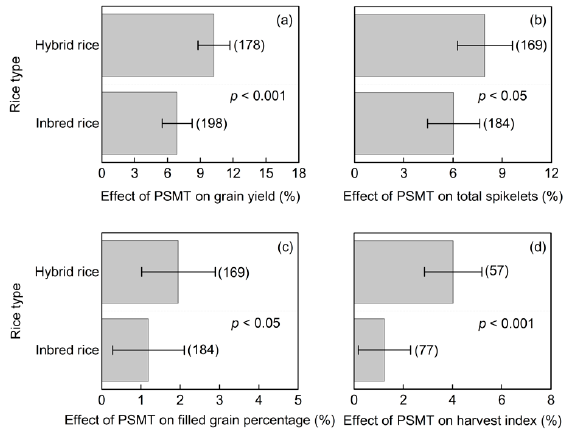
Figure 3. Effects of potted-seedling machine transplantation (PSMT) on grain yield ( a ), total spikelets ( b ), filled grain percentage ( c ), and harvest index ( d ) as affected by rice types in paddies. The numbers near the error bars denote the number of observations for each variable. Error bars represent 95% confidence intervals, and p values indicate the results of a Wald-type test for differences between classes.